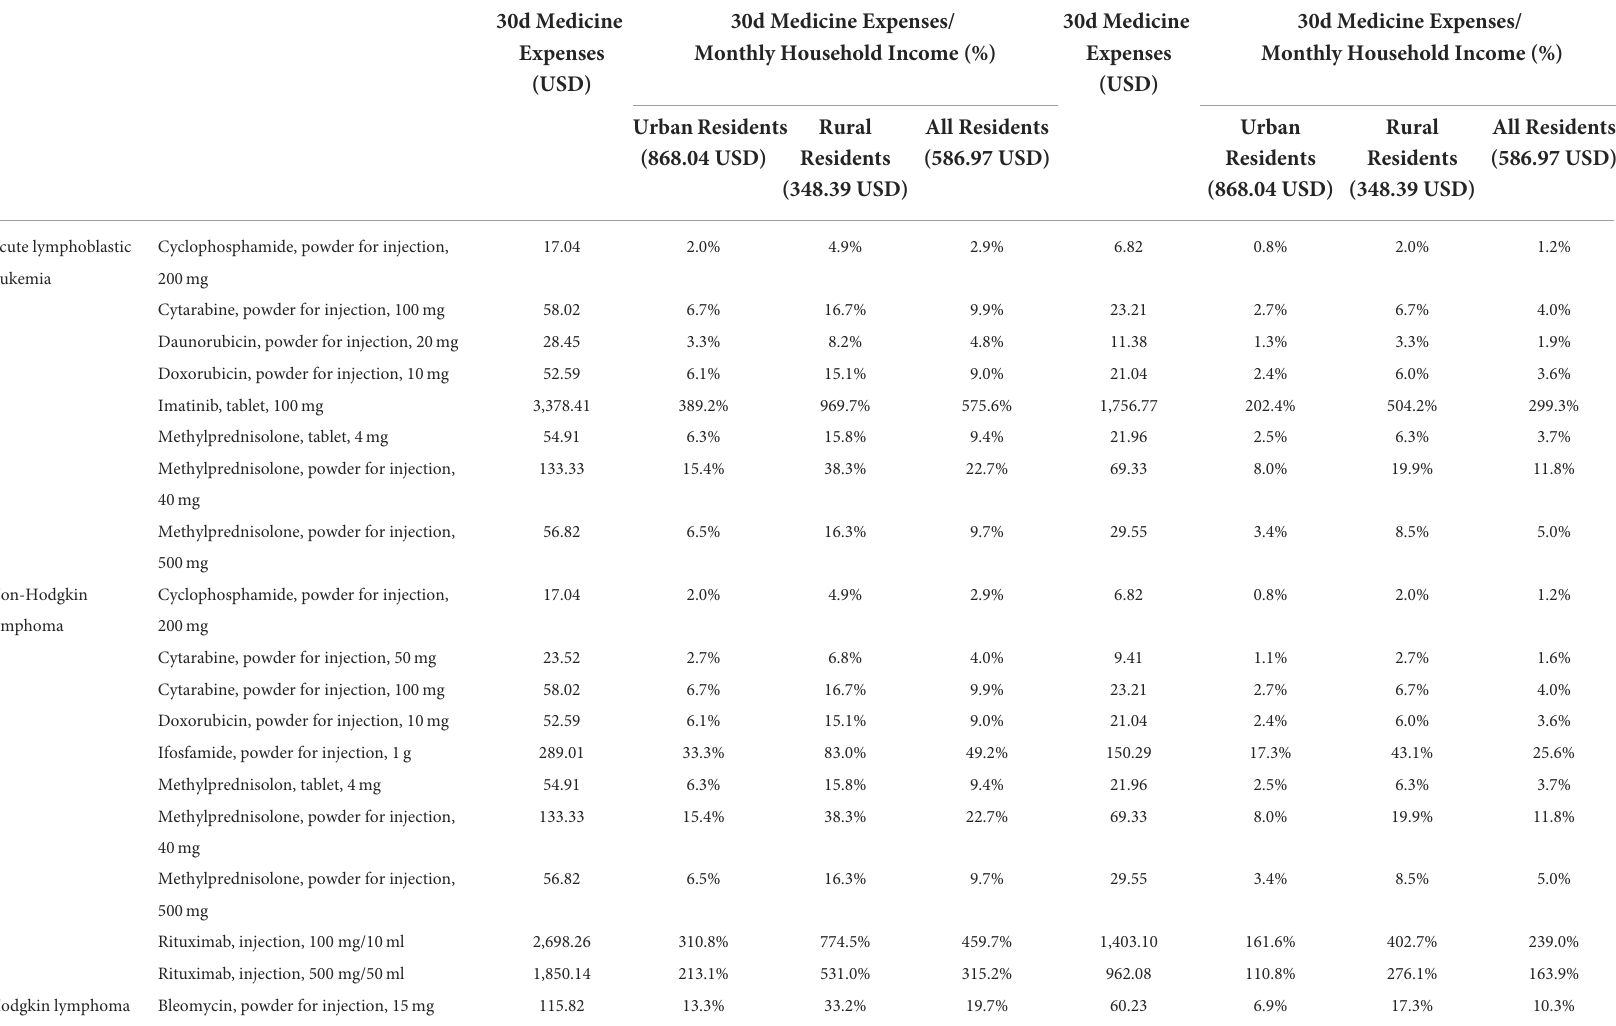
TABLE 4 Affordability of original brands before and after medical insurance